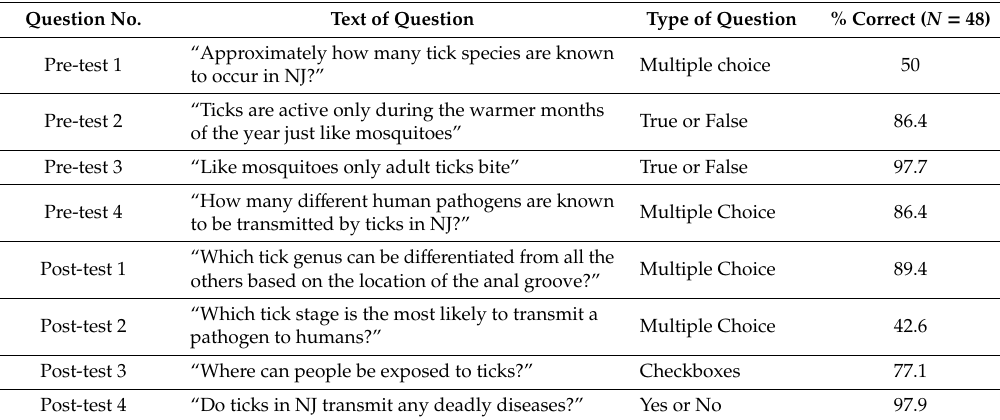
Table 1. Graded responses to pre- and post-tests taken at Tick Blitz workshop on 4 May 2018. Question